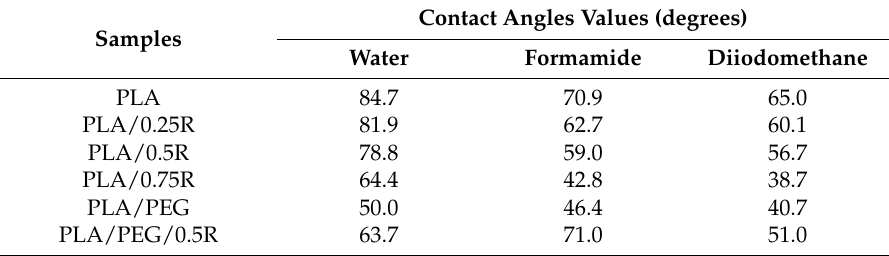
Table 10. The contact angle values ( θ ) between liquids (water, formamide, or diiodomethane) and surfaces of the sample of different compositions.